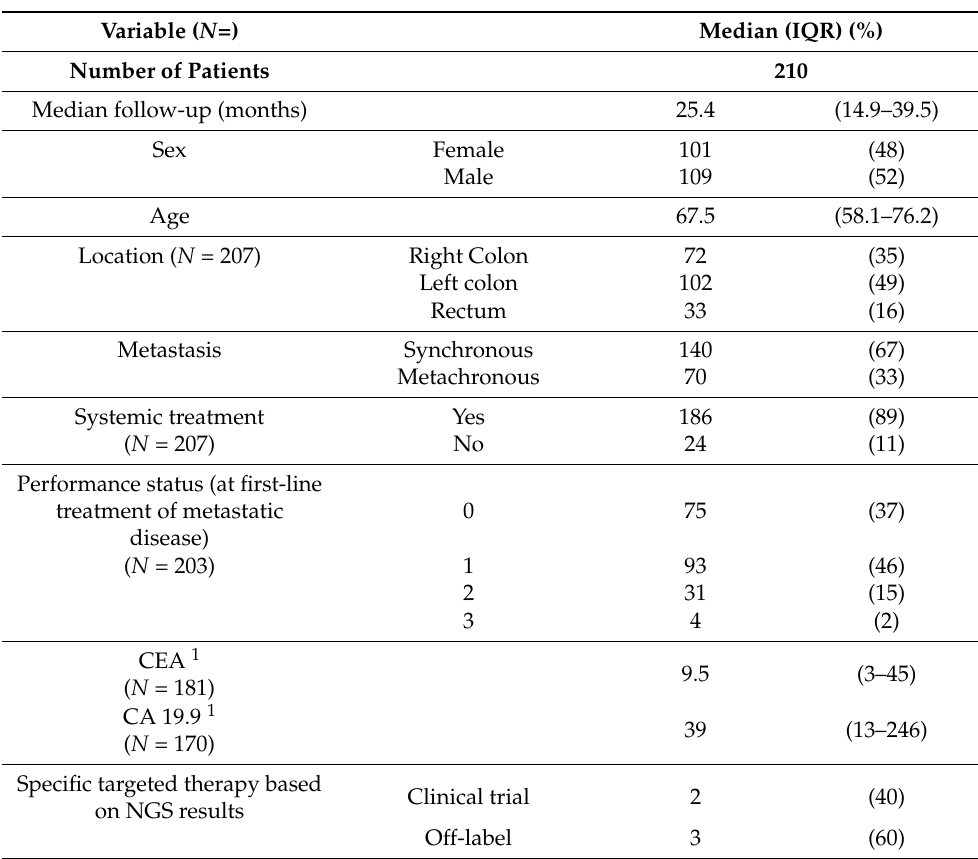
Table 1. Patient